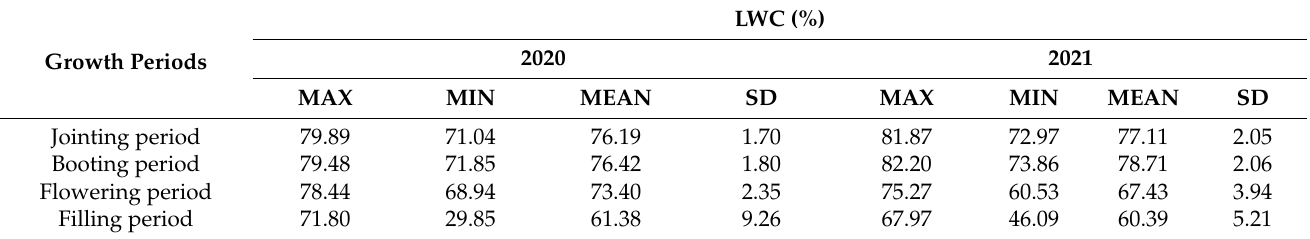
Table 1. Statistical characteristics of LWC from each growth period in different years.